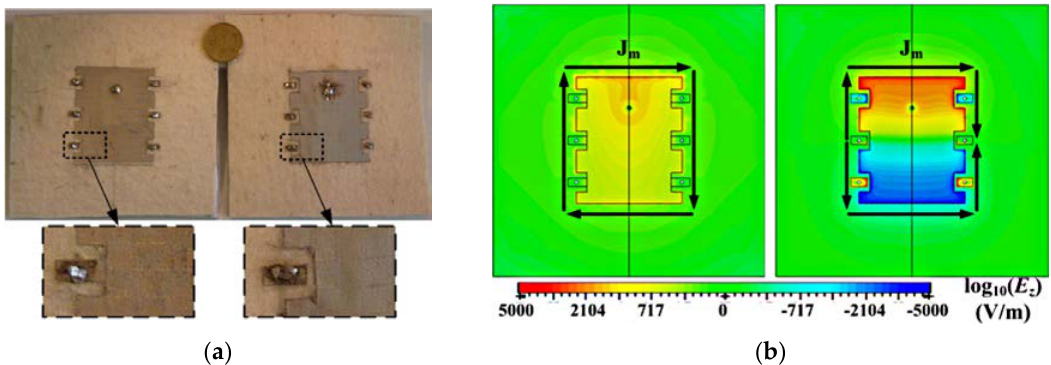
Figure 12. Radiation pattern-reconfigurable wearable antenna based on metamaterial structure [105]. ( a ) The photo of the wearable antenna. ( b ) Two electrical field distributions at 2.45 GHz in z-direction. The first distribution is Patch mode (n = +1) and second one is monopole mode (n = 0). The arrows in the figures represent the direction of the equivalent magnetic current.